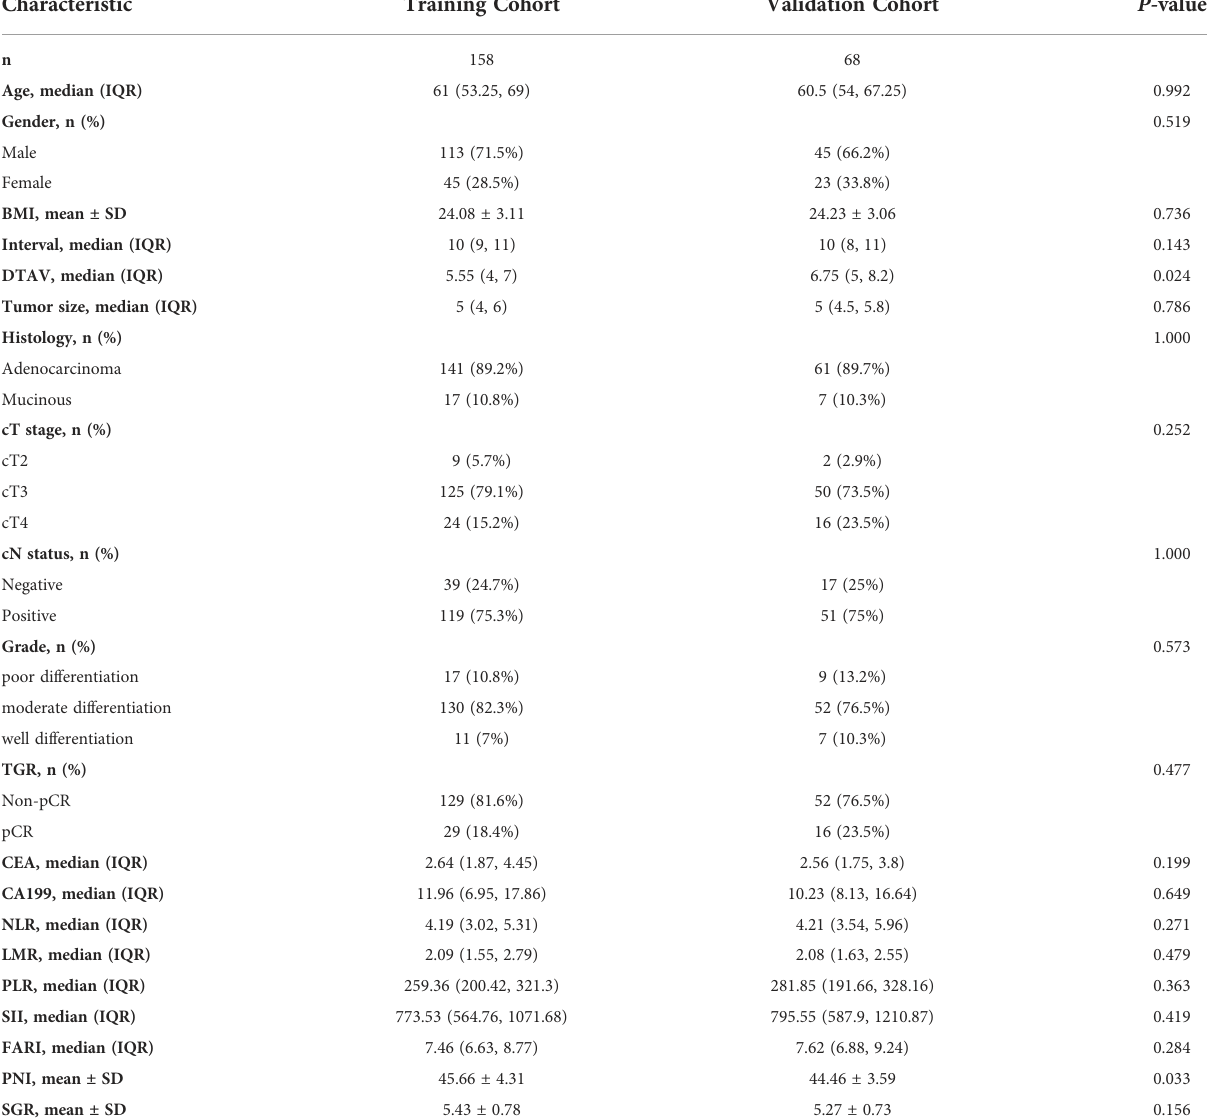
TABLE 1 Clinical characteristics of patients in the training and validation